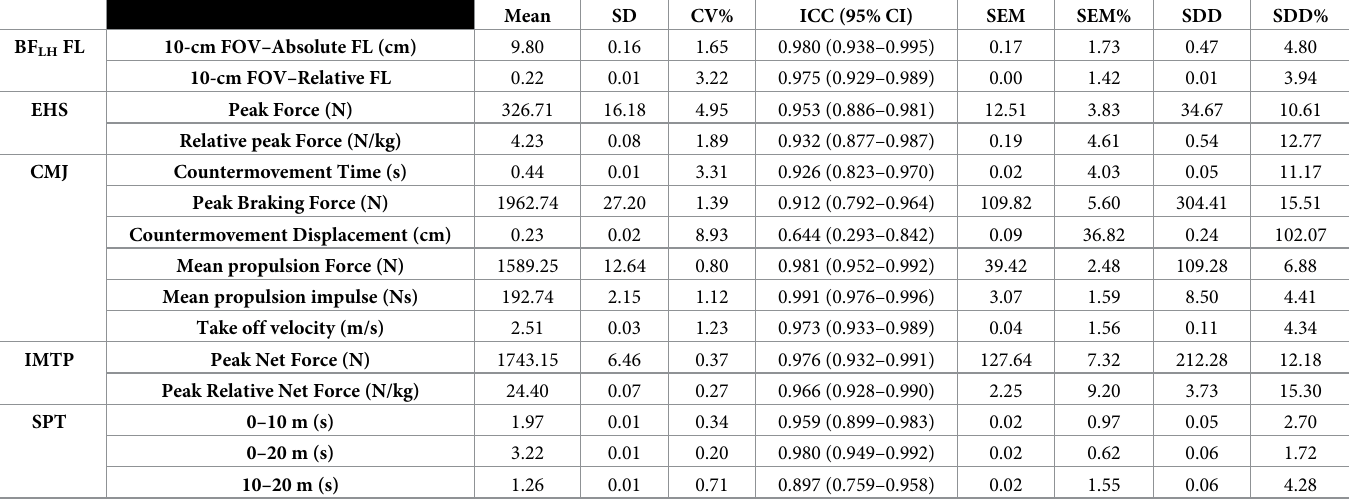
Table 3. Descriptive and reliability statistics for BF LH FL for both 10 cm FOV.